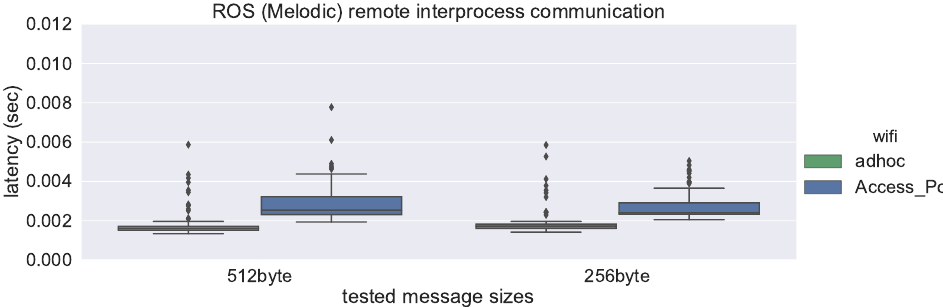
Figure 15. ROS and ROS2 remote interprocess communication with default configuration using WiFi infrastructure mode.